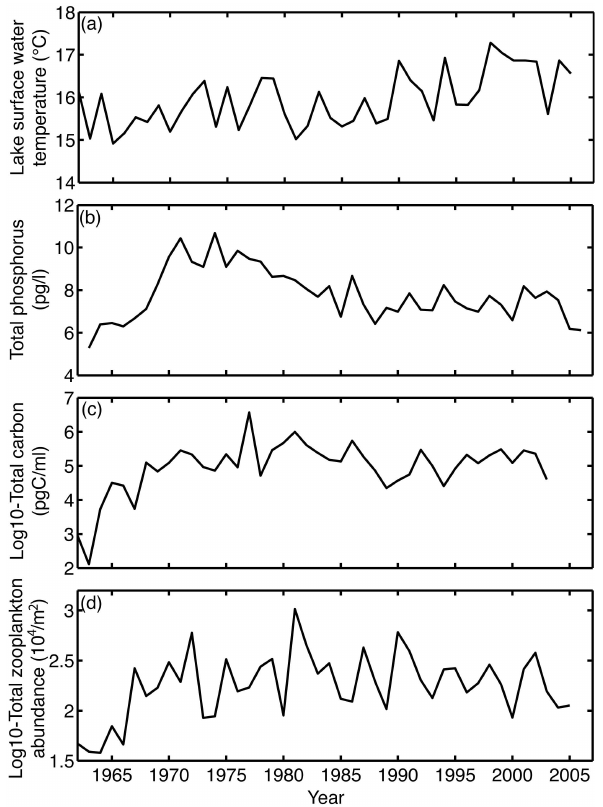
Fig. 3. Time series of (a) annual averaged lake surface water tem- perature and (b) estimated average total phosphorus in upper 20m, (c) estimated phytoplankton carbon biomass, and (d) total water column integrated zooplankton abundance averaged over 5